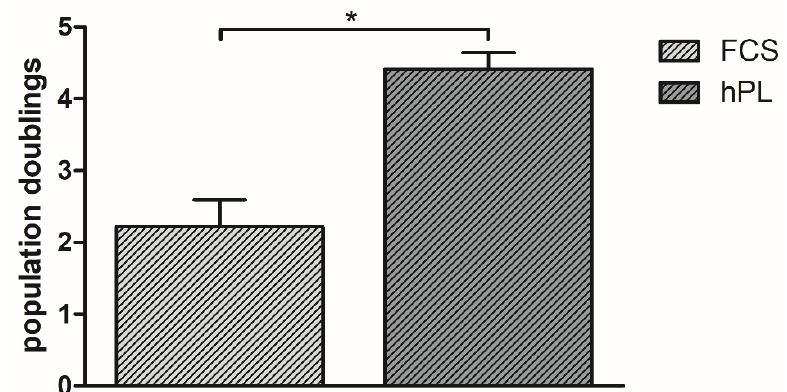
Figure 1. Population doublings of BMSC incubated in ESM. Values are presented as means with SD, * marks significant differences.